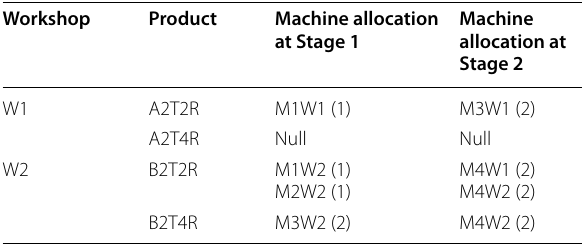
Table 3 Testing machine allocation scheme